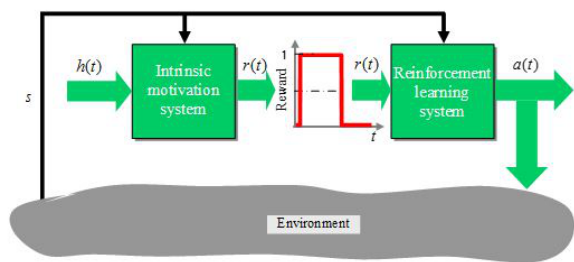
Figure 7: Learning as a function of reward and environmental states.